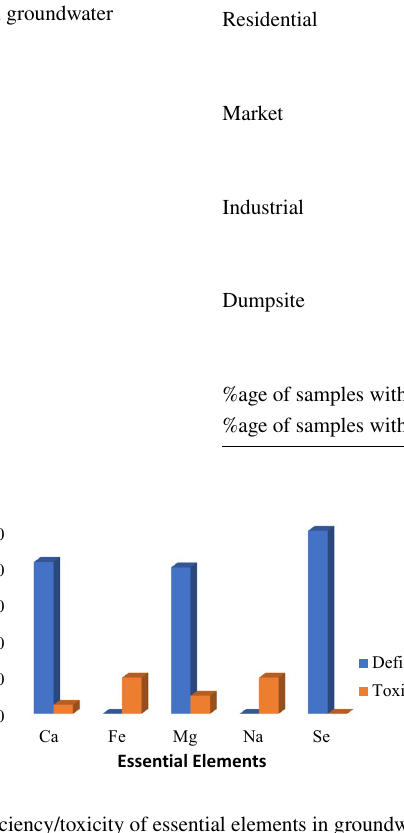
Table 1 Summary of concentration of essential elements in groundwater